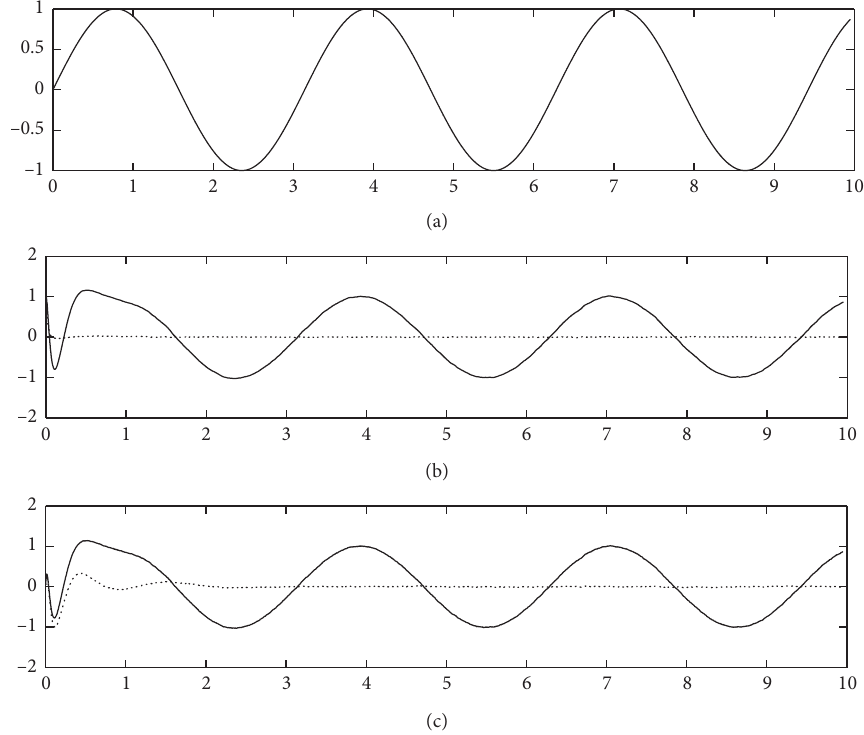
Figure 8: Tracking control of continuous-time chaotic system with trajectories (a) x